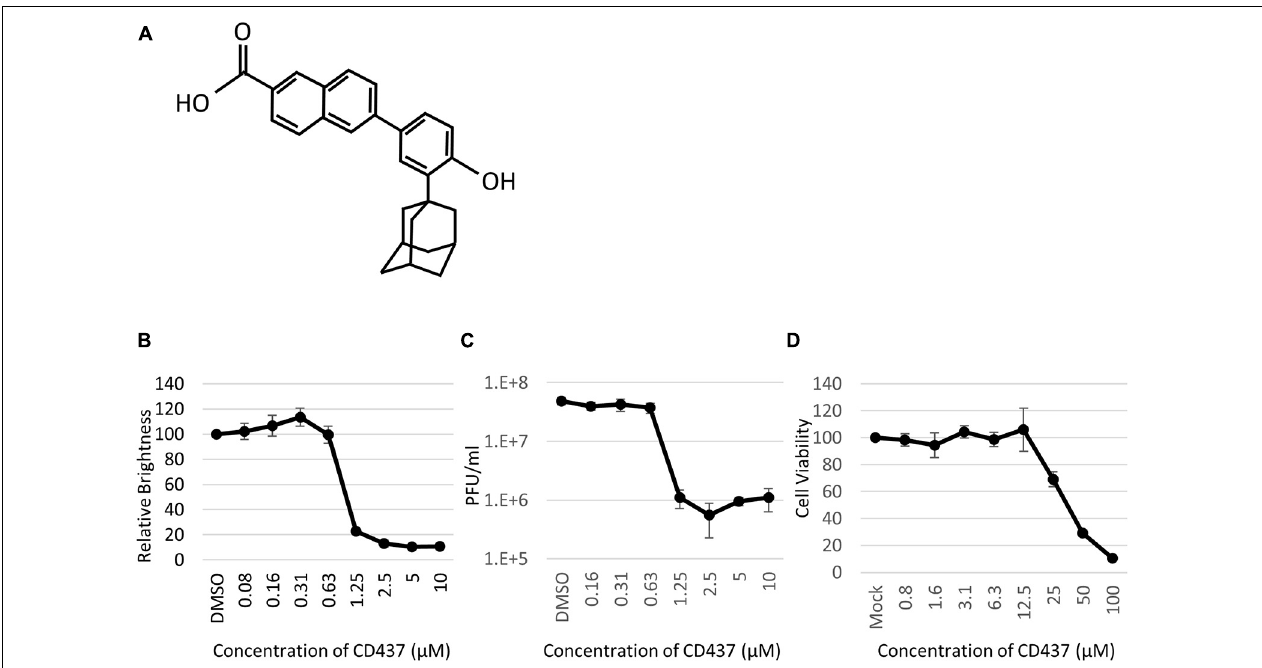
FIGURE 2 | CD437 inhibited MuV replication. (A) Structure of CD437. (B) CD437 inhibited MuV replication in a dose-dependent manner. A total of 0–10 µ M of CD437 was co-cultured with AcGFP-MuV at an MOI of 0.01 in IFNAR1-KO A549/hSLAM cells. At 72 h post-infection, GFP brightness was measured using a fluorescence microscope and image analyzer. EC 50 was calculated using the Reed and Muench method. (C) CD437 inhibited MuV replication in a dose-dependent manner. A total of 0–10 µ M of CD437 was co-cultured with AcGFP-MuV at an MOI of 0.01 in IFNAR1-KO A549/hSLAM cells. At 72 h post-infection, the supernatant was collected and the infectious titer was measured by plaque assay. The EC 50 was calculated using the Reed and Muench method. (D) Cytotoxicity of CD437; 0–100 µ M of CD437 was co-cultured in IFNAR1-KO A549/hSLAM cells and cell viability was measured at 72 h after culture was started using WST-8 reagent. The CC 50 was calculated using the Reed and Muench